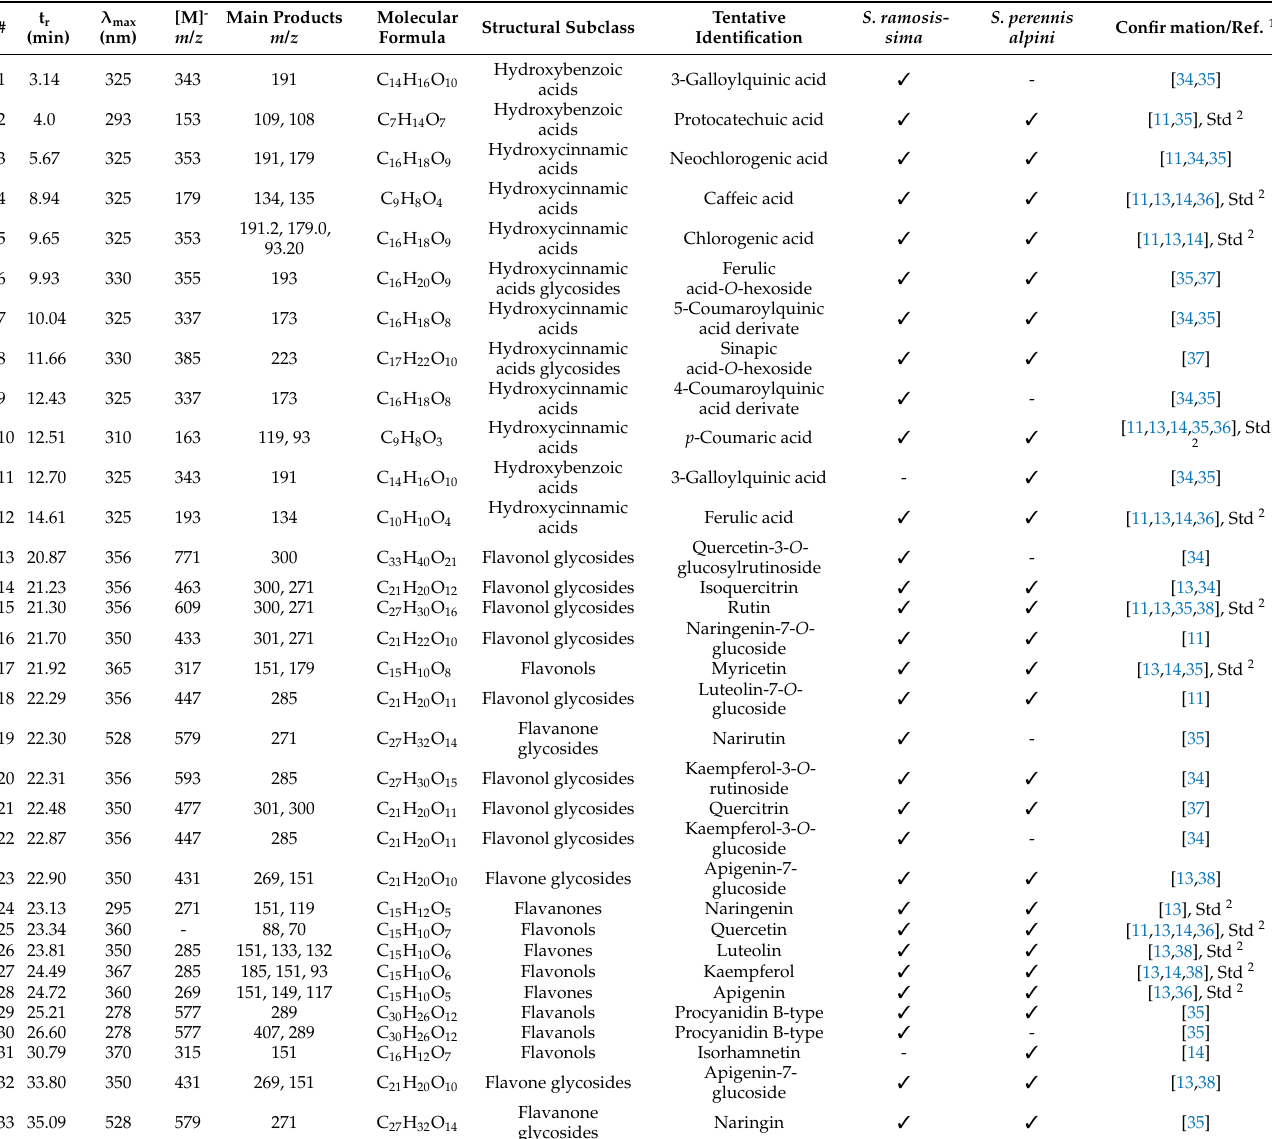
t r —retention time; λ max —maximum absorption wavelengths; [M] − —molecular ions; (cid:51) —indicates the presence of the compound identified; 1 Ref.—references used to support tentative identification of compounds or 2 Std (standards available) to confirm the